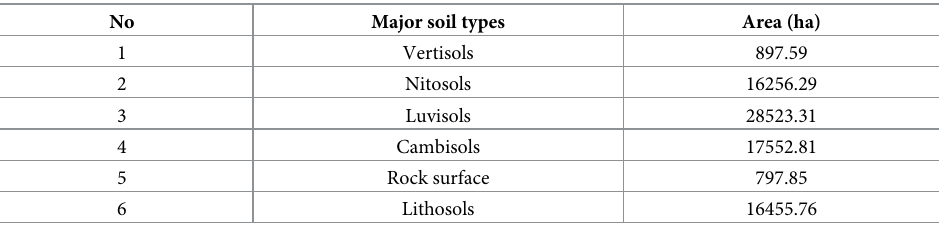
Table 1. Soil types and area coverage of the study area.